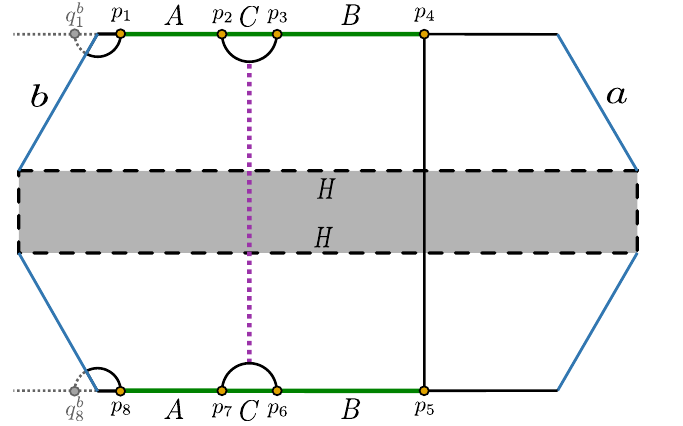
Figure 28 . The endpoints of the intervals A and B and the image points in the two BCFT 2 copies are identified similarly as in figure 20 with p 4 = p 5 = r 4